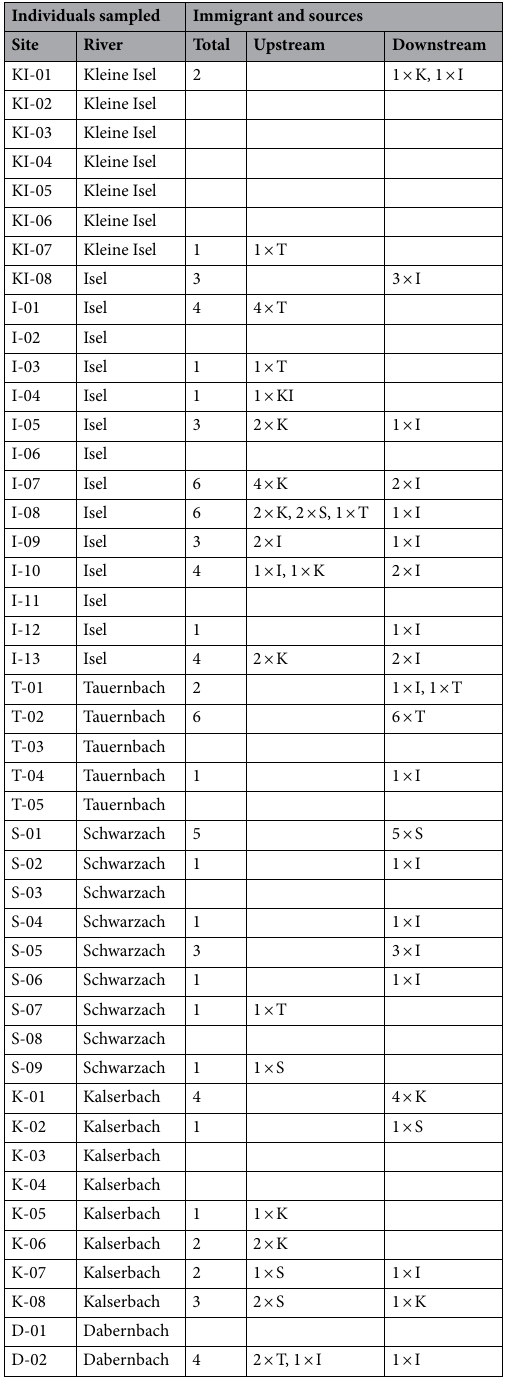
Table 3. Detection of first-generation migrants in populations along Isel and its tributaries, and their most probable upstream and downstream source populations ( p < 0.01). KI = Kleine Isel, I = Isel, T = Tauernbach, S = Schwarzach, K = Kalserbach, D =